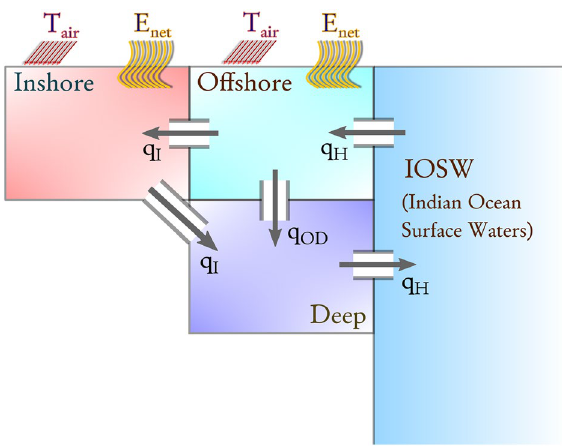
Figure 2. Conceptual scheme of the box model (see “Methods” for the model equations). Volume fluxes ( q I , q H , q OD ) between the Indian Ocean, inshore, offshore, and deep boxes are driven by the density differences between the water masses in adjacent boxes. The inshore and offshore boxes are subject to evaporation and heat exchanges with the atmosphere. The flux q H quantifies the water exchange between the Indian Ocean and the Gulf through the Strait of